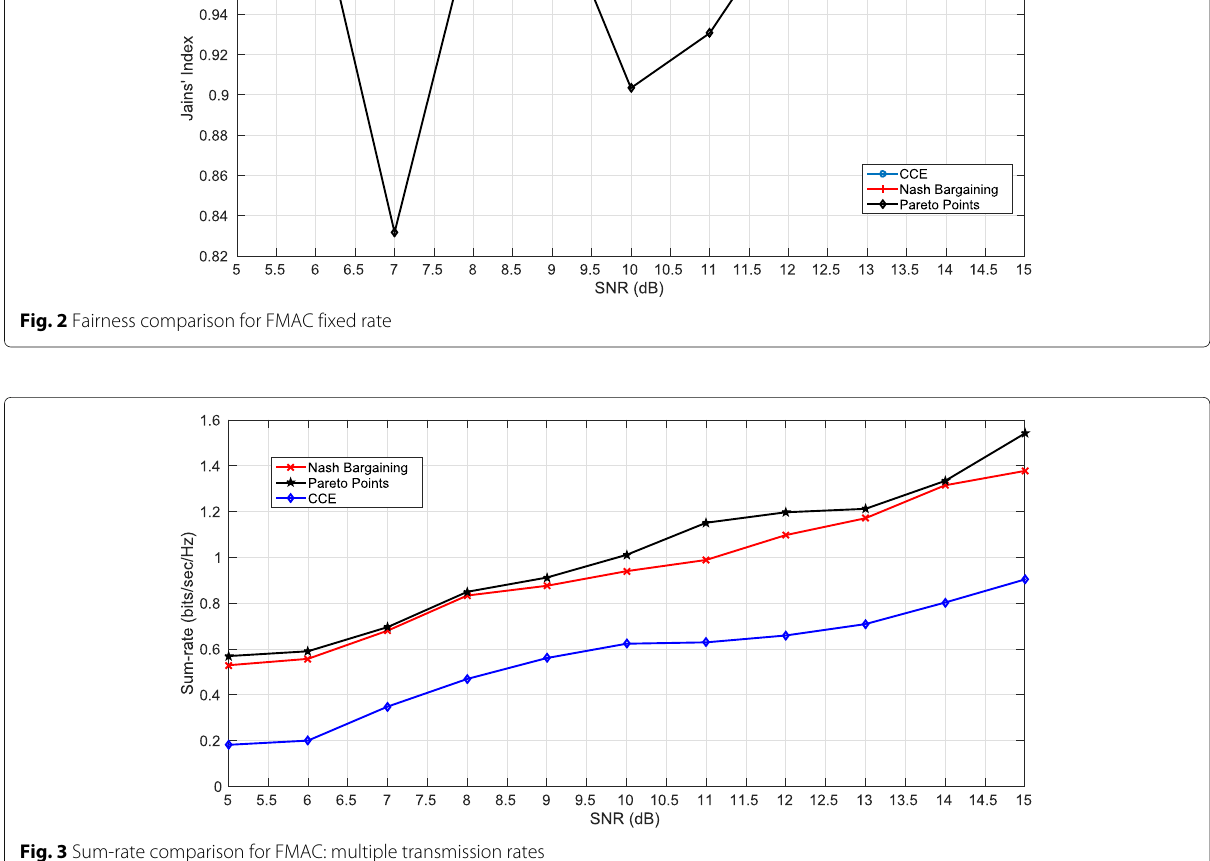
Fig. 3 Sum-rate comparison for FMAC: multiple transmission rates